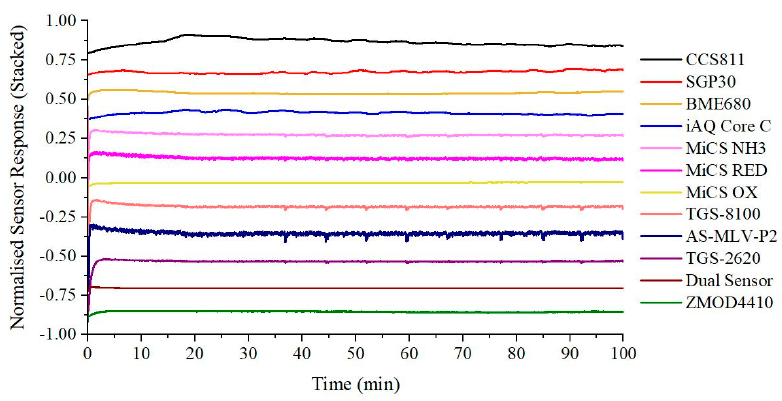
Figure 10. Warm-up and baseline stabilisation output response.